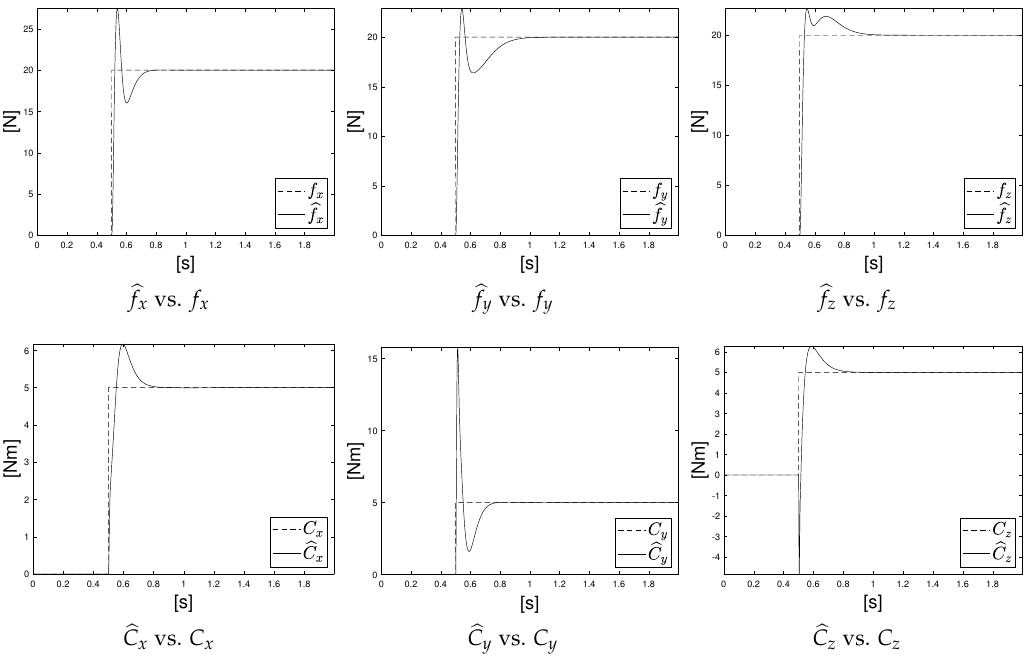
Figure 1. Estimated interaction forces (cid:98) f and torques (cid:98) C (continuous line) vs. real interaction forces f and torques C (dashed line) for the #1 simulation